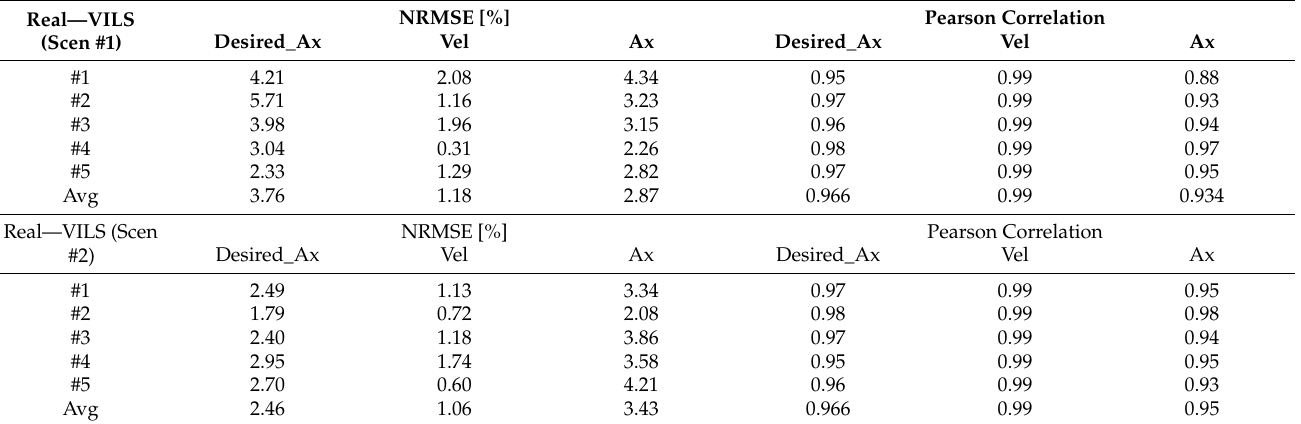
Table 4. Data Comparison Result—Longitudinal behavior (Desired longitudinal acceleration, Velocity and Longitudinal acceleration) KPI.